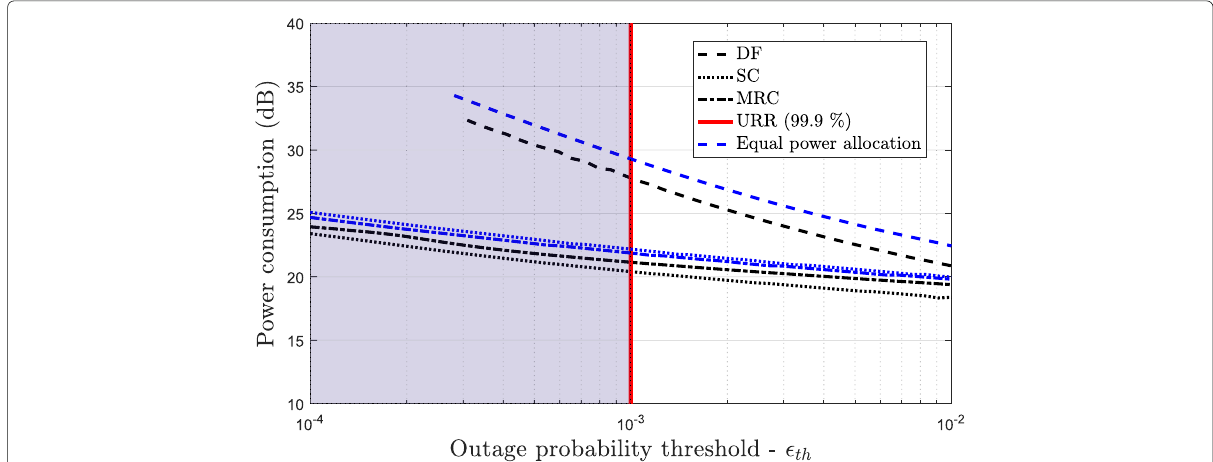
Fig. 11 Total power consumption of DF, SC, and MRC under EPA and OPA constraints. This figure indicates the total power consumed in each of studied cooperative schemes. We show that under EPA strategy MRC consumes less energy compared to DF and SC scenarios while under OPA strategy, SC becomes the most energy-efficient